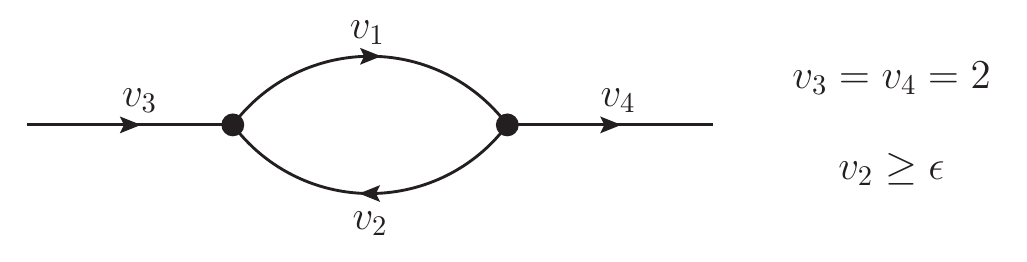
Figure 2. Example of a toy reaction network. The black dots are two metabolites, to each of which corresponds a mass balance constraint. Each line is labeled with the name of the flux carried by a reaction, and the arrow indicates the conventional forward direction of the fluxes. Evidently, a thermodynamically infeasible cycle is present if v same